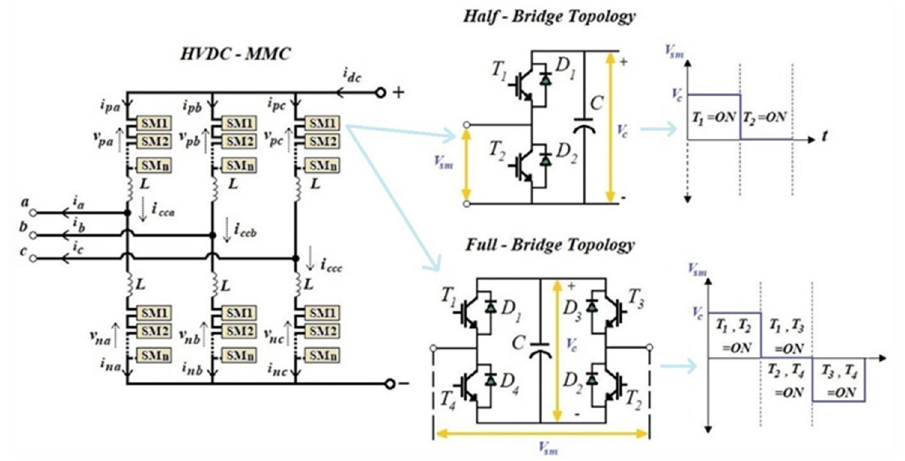
Figure 23. MMC-HVDC “half-bridge” vs. “full-bridge” topology.